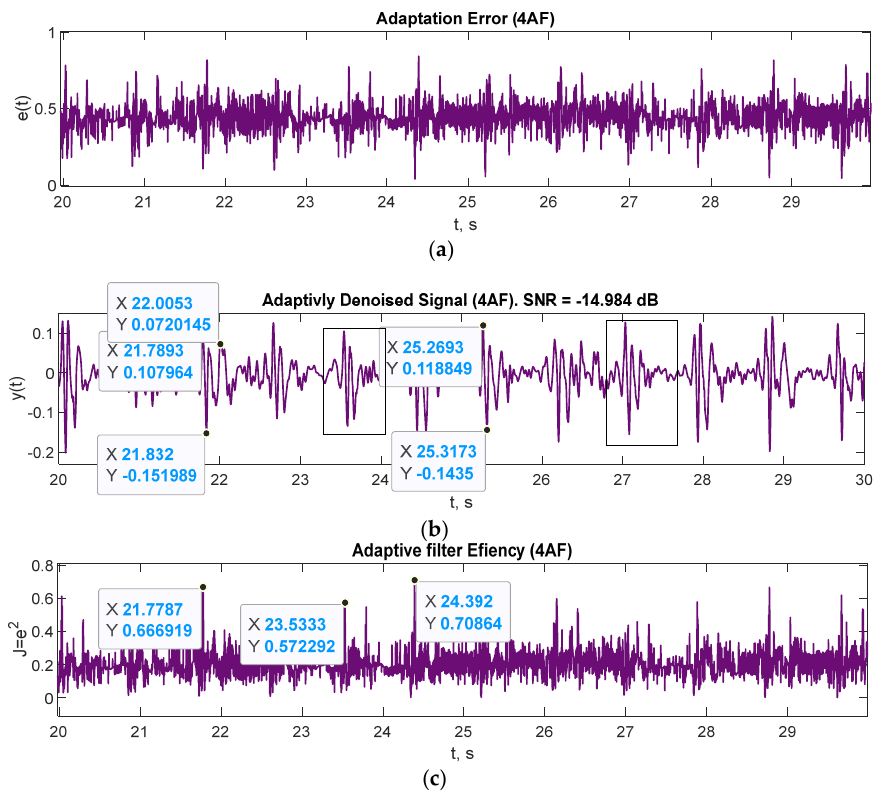
Figure 9. Processing SCG signal in the second adaptive filter with sample delay order 5 and IIR filter in the input. ( a ) Adaptation error of the second adaptive filter. ( b ) Adaptively filtrated signal. ( c ) The efficiency of the adaptive filter.